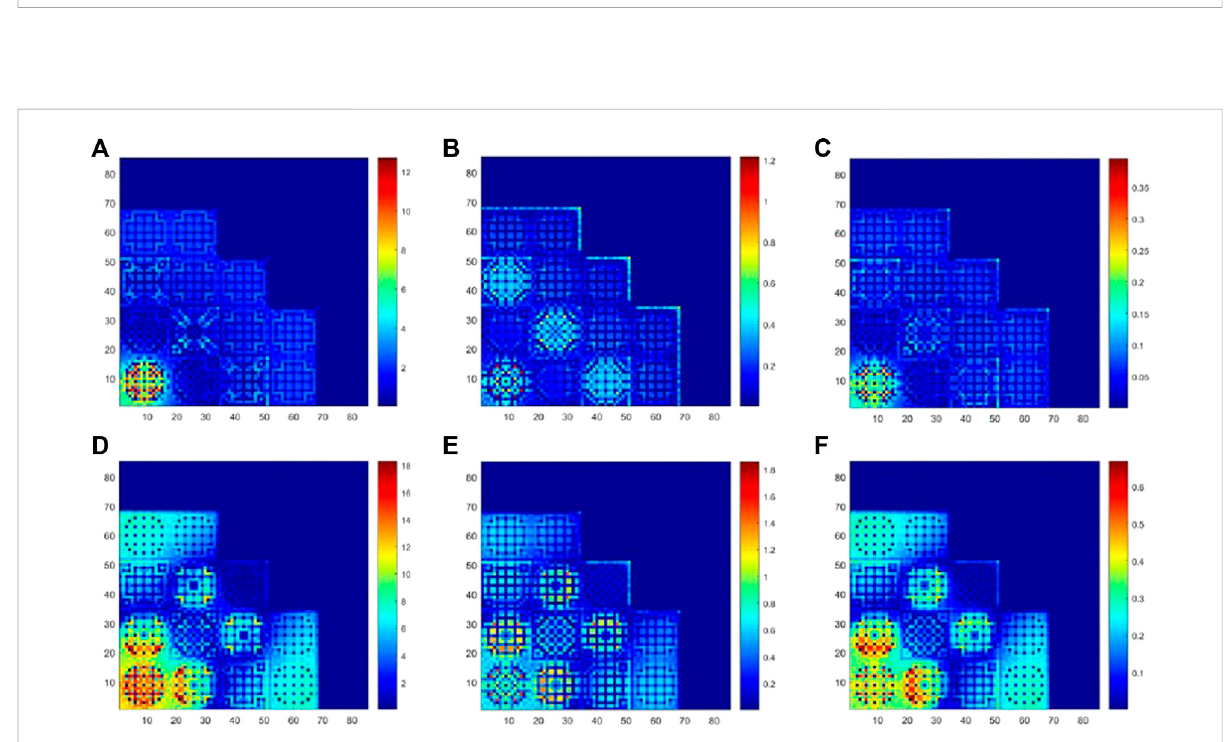
FIGURE 5 Relative error (%) of pin-wise power density on different mesh sizes per pin compared with those on 32 × 32 meshes per pin for 2-D KAIST-3A benchmark problems using the comePSn_JFNK code: (A) 1 × 1 for ARO, (B) 2 × 2 for ARO, (C) 4 × 4 for ARO, (D) 1 × 1 for ARI, (E) 2 × 2 for ARI and (F) 4 × 4 for